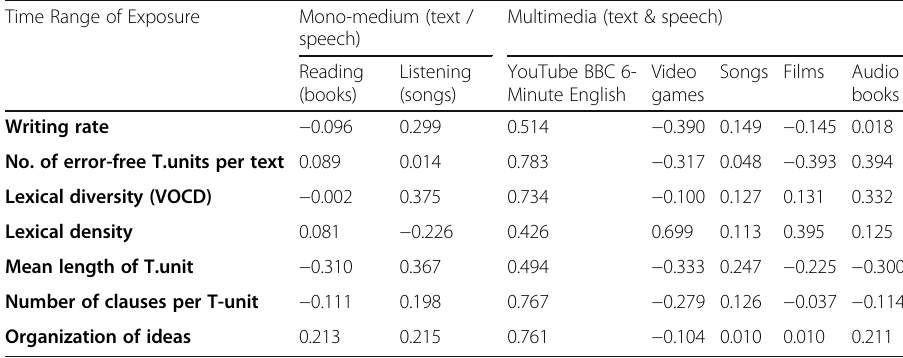
Table 3 Pearson ’ s correlation coefficient: Time Range of Exposure (Online learning) Time Range of Exposure